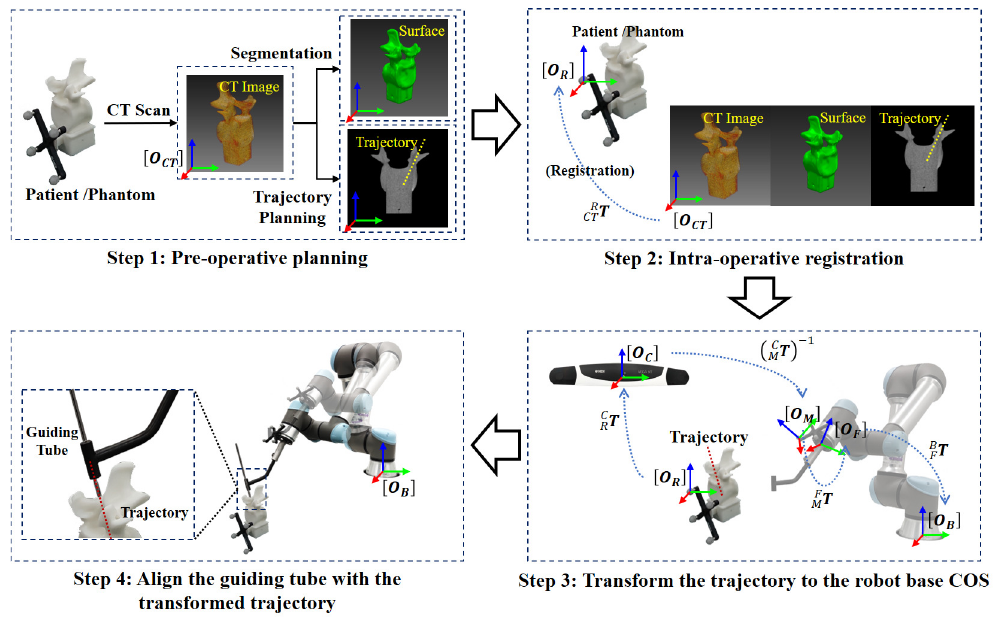
Figure 5. A schematic view of robot-assisted pedicle screw insertion: The target trajectory is planned in the COS O CT and transformed to the COS O R by intra-operative registration. The target trajectory is further transformed to the robot base COS O B . The guiding tube is aligned with the target trajectory for insertion